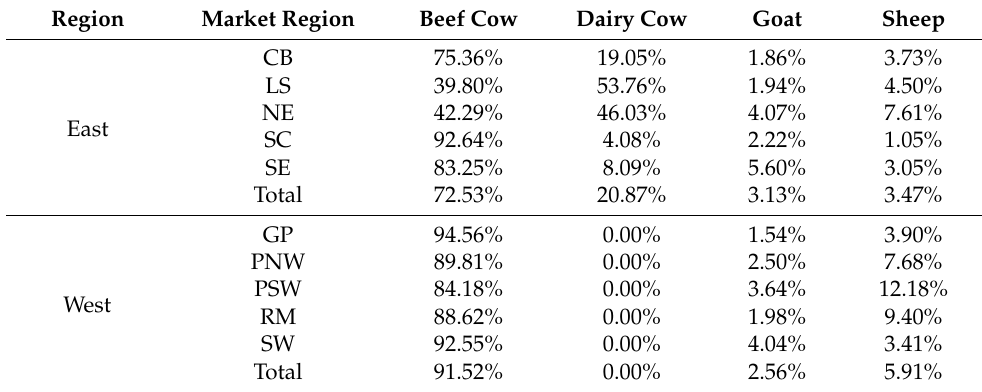
Table 3. Average land share of livestock by region. Region Beef Cow Dairy Cow Goat